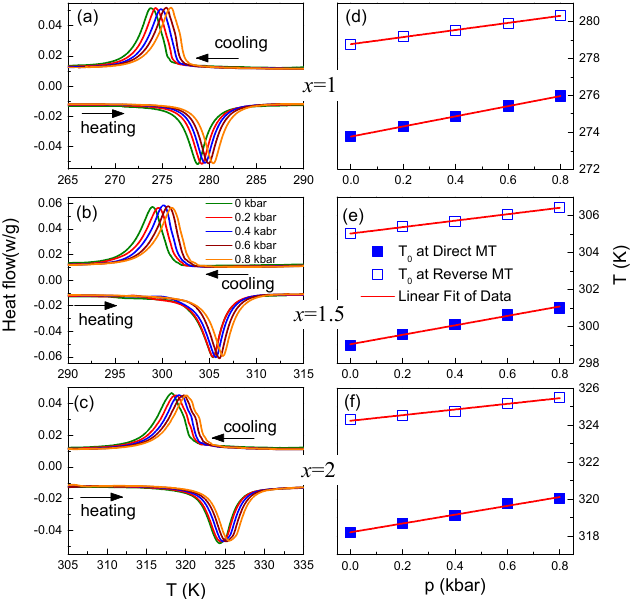
Figure 3. ( a – c ) The heat flow curves measured at applied hydrostatic pressure in the range of 0 to 0.8 kbar for Co 50 V 34 Ga 16 − x Fe x alloys. ( d – f ) The applied hydrostatic pressure dependence of equilibrium temperatures at forward ( T 0 ) and reverse ( T (cid:48) ) MTs for these alloys; the red solid line is their best linear fit.